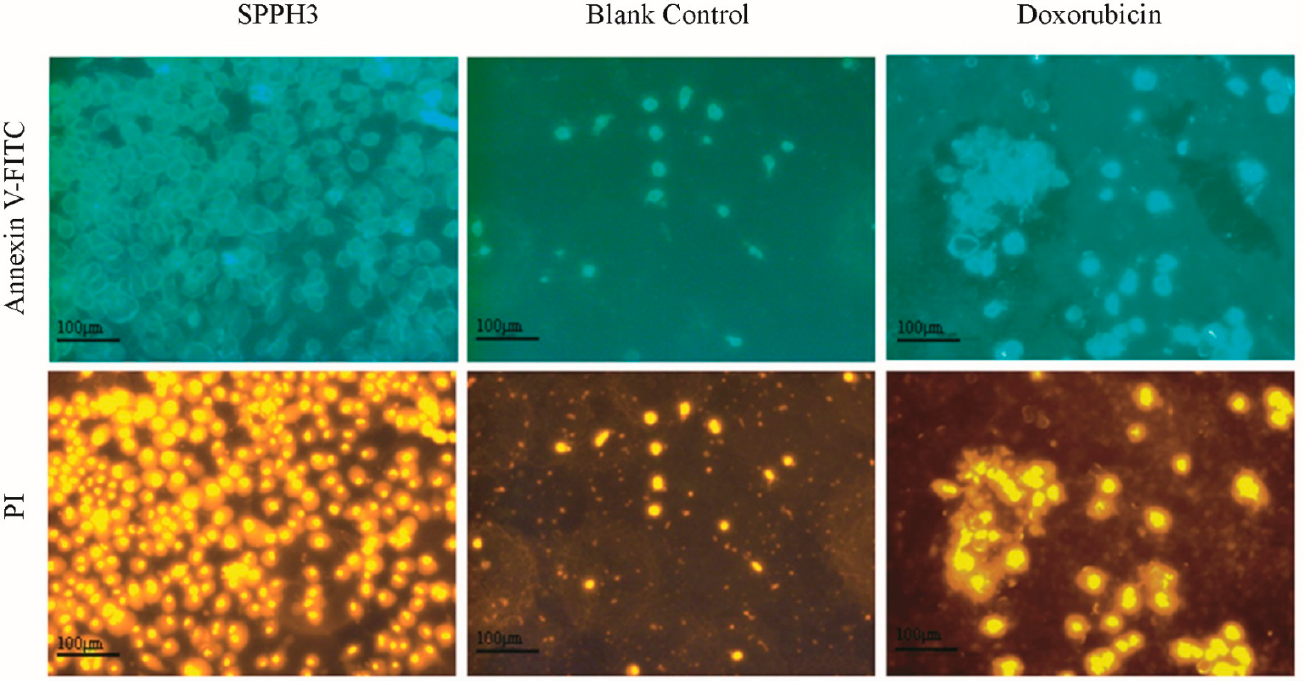
Figure 4. Cell morphology observed by a fluorescence microscope after treatment with SPPH3 and Doxorubicin. Fluorescence microscope images of MGC-803 cells incubated without (Blank Control) or with SPPH3 (0.31 mg/mL) or Doxorubicin (0.001 mg/mL) for 24 h, respectively. Cells were stained with Annexin V-FITC and PI. Images were captured by a fluorescence microscope at ×200 magnification. Scale bar = 100 μ m.